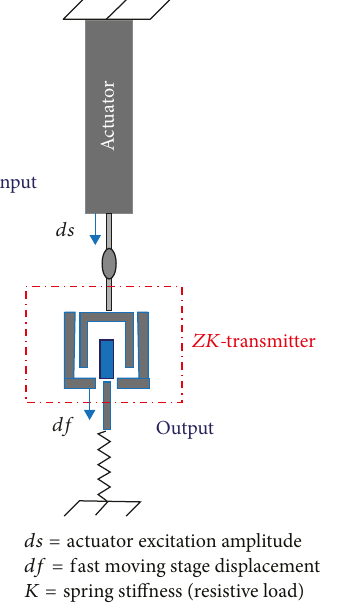
Figure 9: Schematic representation.